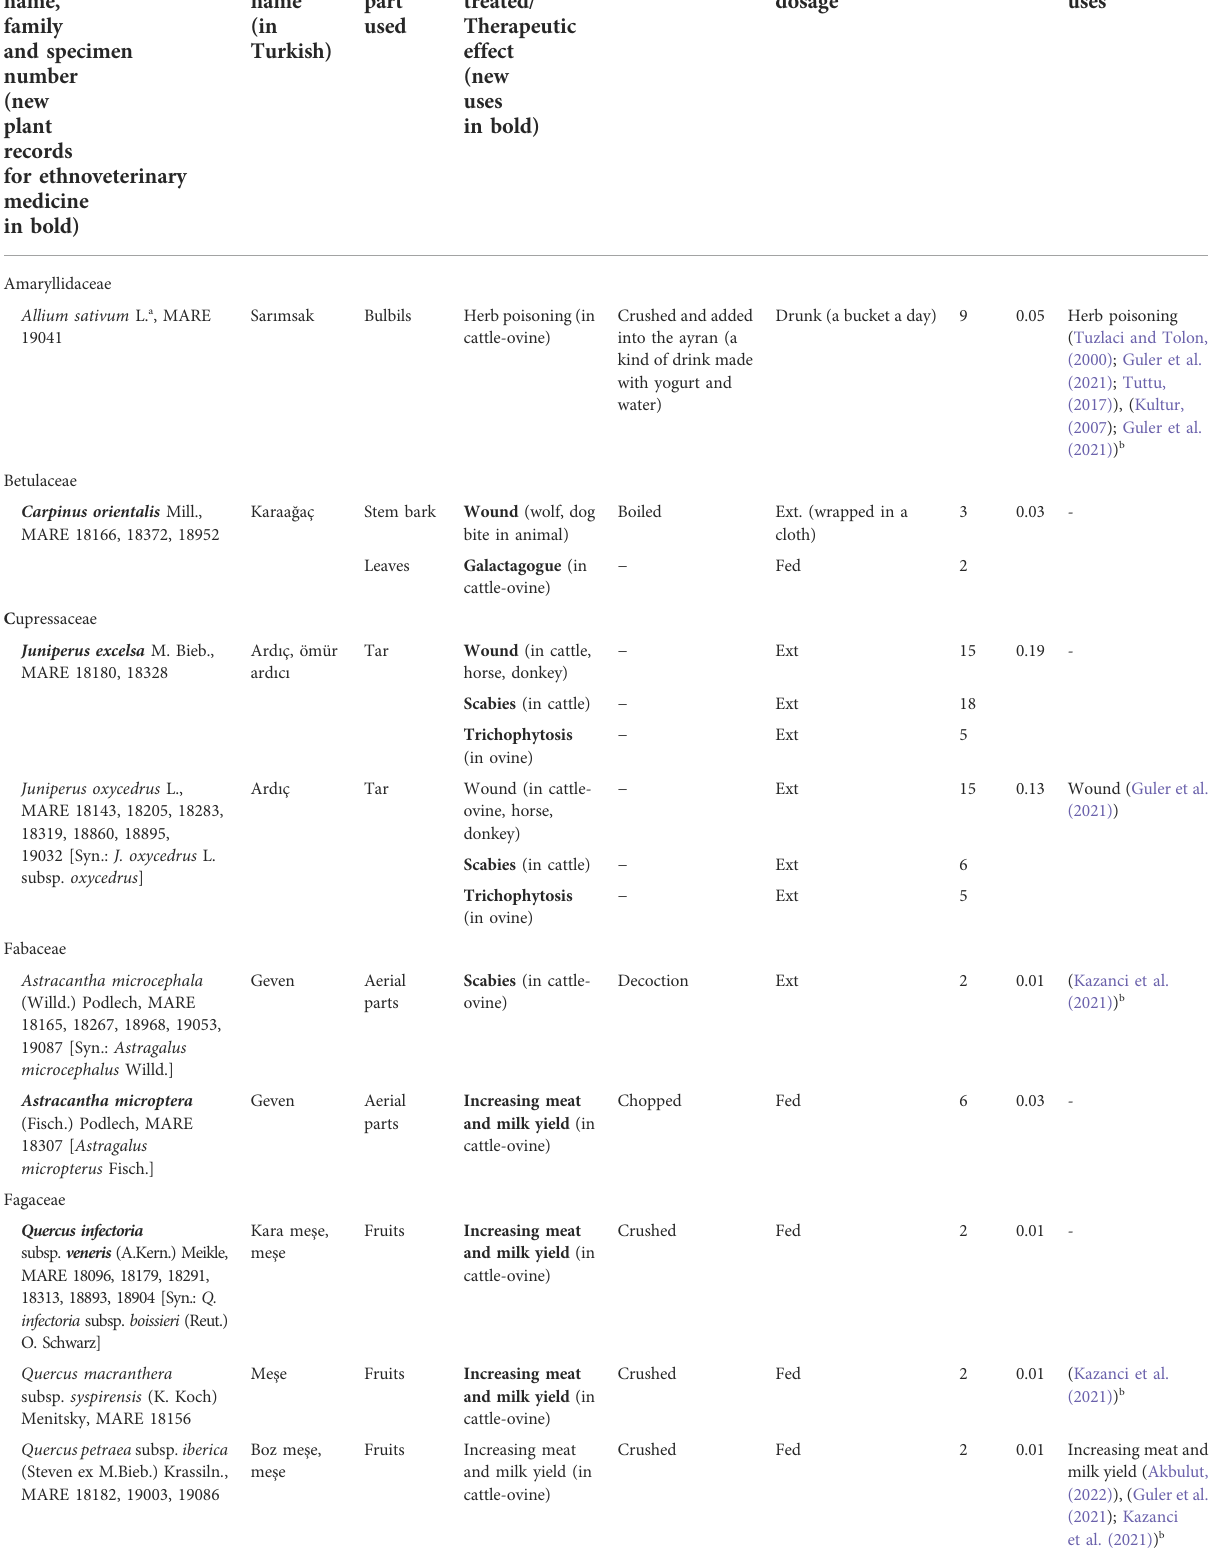
TABLE 1 The plants used in ethnoveterinary medicine in Ta ş köprü (Kastamonu/Turkey). Botanical name, family and